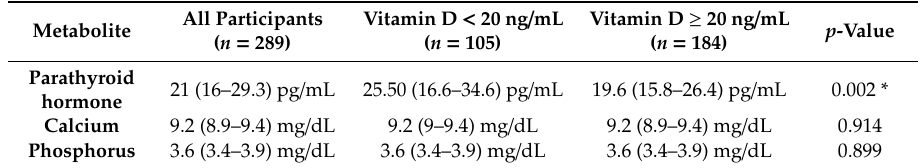
Table 2. Concentrations of parathyroid hormone, calcium and phosphorus based on 25-hydroxyvitamin D cut-o ff points.